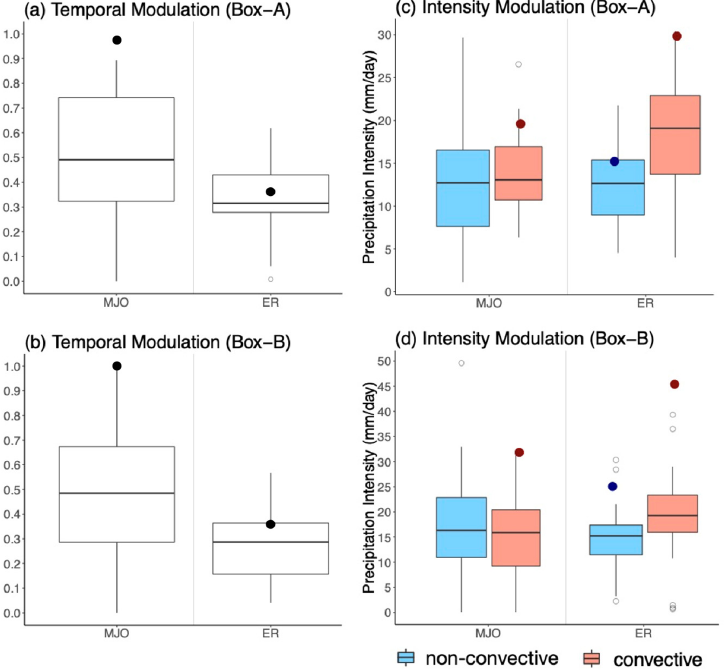
Figure 5. ( a , b ) Temporal modulation measured by a percentage in the entire period (15 days) of an SPRE that is associated with the convective phases of MJO or ER wave in ( a ) Box-A and ( b ) Box-B areas. ( c , d ) are the intensity modulation measured by a comparison of the mean rainfall intensity during the convective phases of MJO or ER passing through the box areas and the mean rainfall intensity during the nonconvective (suppressed or no-wave days in ( c ) Box-A and ( d ) Box-B. The convectively active CCEWs days are identified when over 50% of the grids achieve the convective threshold for each wave. Boxplots are the statistics using climatological SPREs from 1998 to 2017, and the solid circles are the condition in 2018/19 SPRE. Outliers are estimated using Tukey [32] fences ( [ Q 1 − 1.5IQR, Q 3 + 1.5IQR ] ) represented in hollow